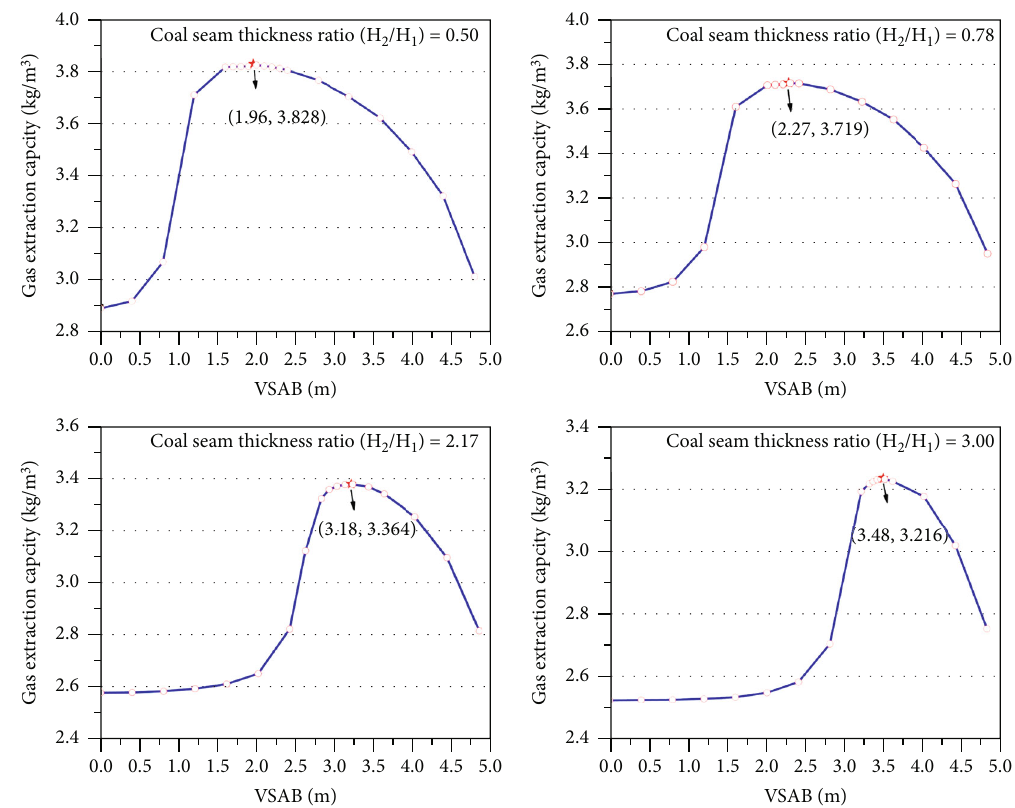
Figure 8: Relationship between gas extraction capacity and VSAB under di ff erent coal seam thickness ratios. Table 4: Comparison of the gas extraction amount under di ff erent simulation cases (300d). Traditional single-row borehole Case